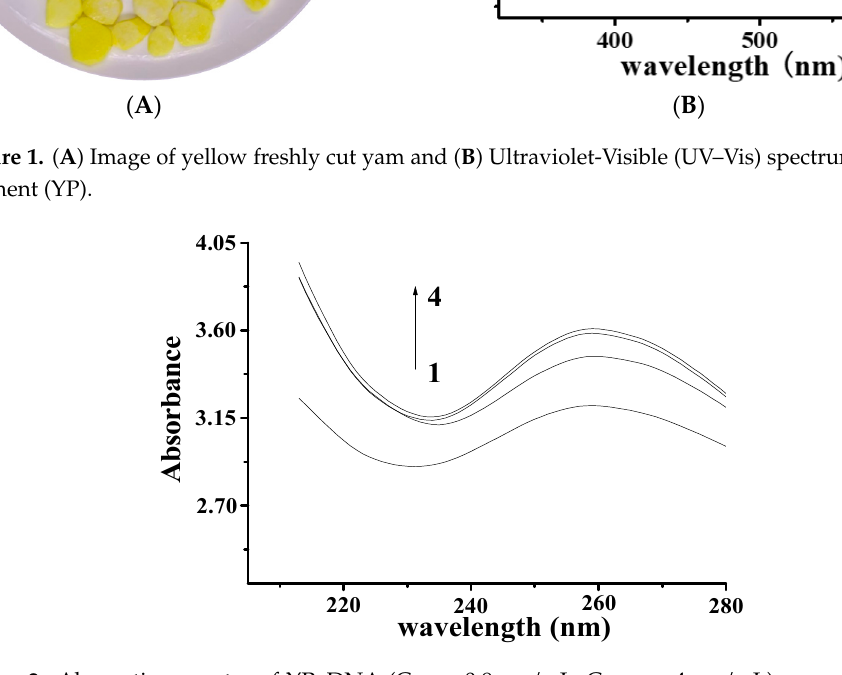
Figure 2. Absorption spectra of YP–DNA (C YP = 0.9 mg/mL, C DNA = 4 mg/mL) upon addition of increasing volume: (1) 0 μ L, (2) 50 μ L, (3) 60 μ L, (4) 70 μ L.